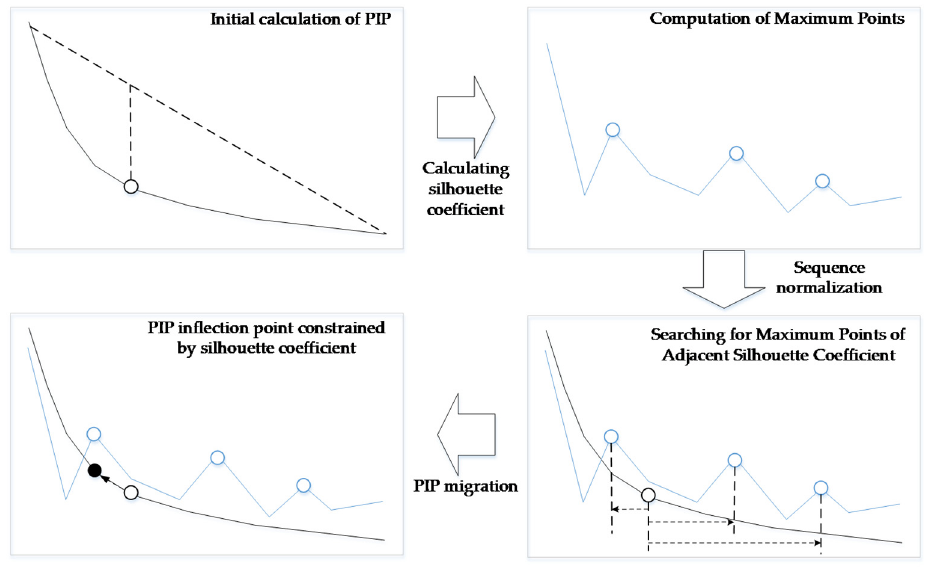
Figure 4. SSE inflection point recognition considering silhouette coefficient.